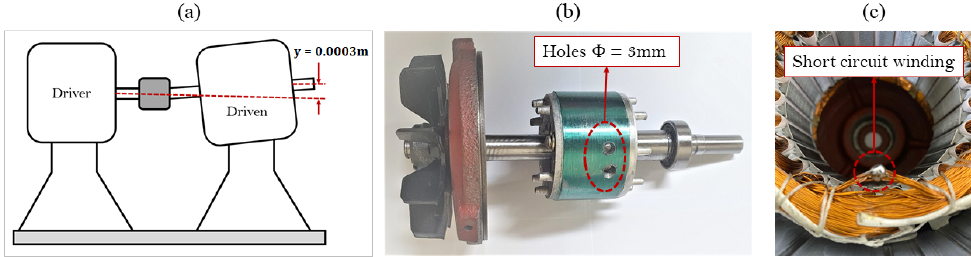
Figure 6. A pictorial view showing a replication of the induced failure modes: ( a ) rotor bar misalign- ment, ( b ) motor broken rotor-bar, and ( c ) turn-to-turn circuit